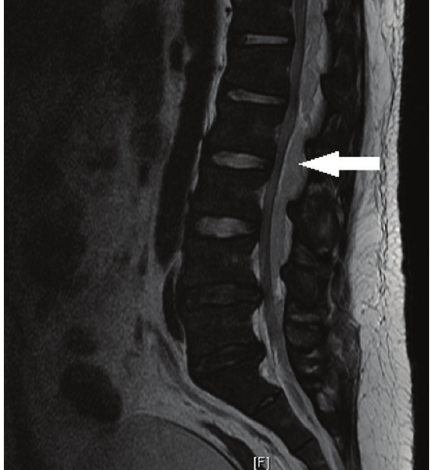
Figure 3: Sagittal view of T2 diffusion MRI lumbar spine showing extensive epidural abscess (arrow) extending from the upper dorsal region all the way to the distal conus medullaris, displacing the thecal